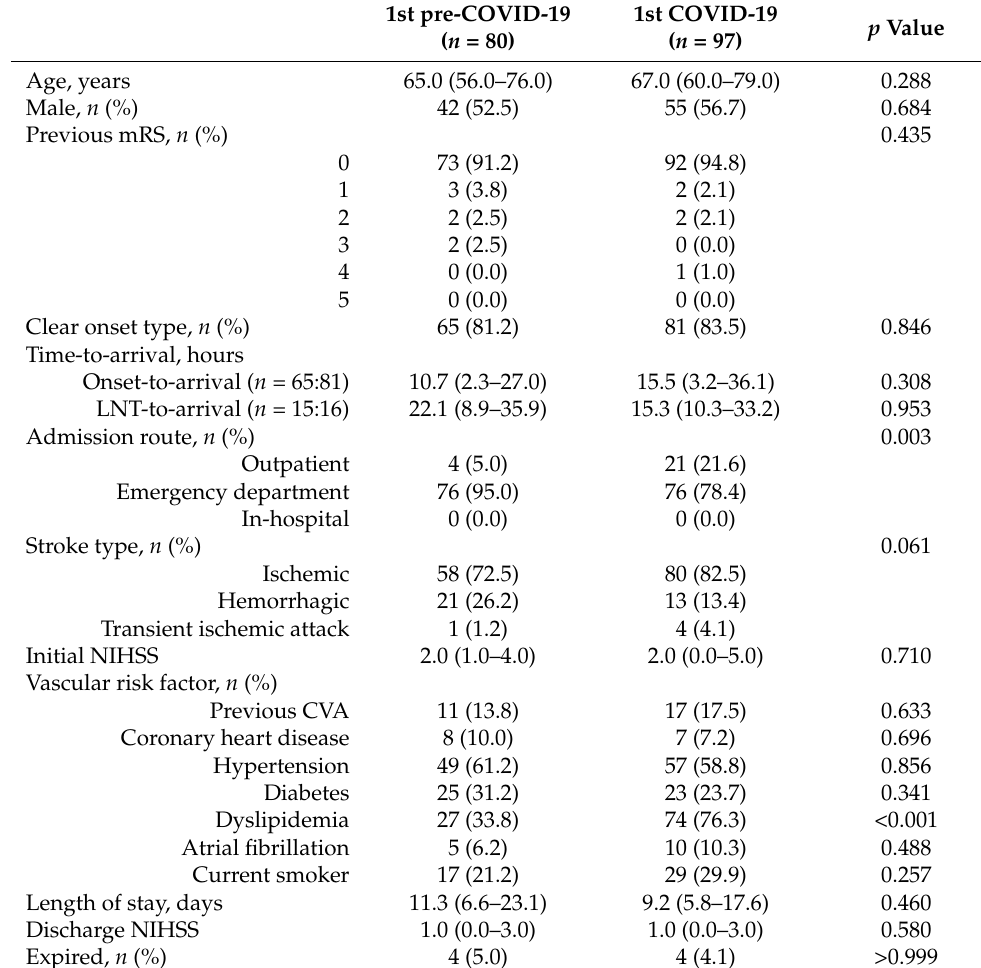
Table 3. Demographic and disease-related characteristics of patients with stroke during Period 1 (the regional COVID-19 outbreak) and the first pre-COVID-19